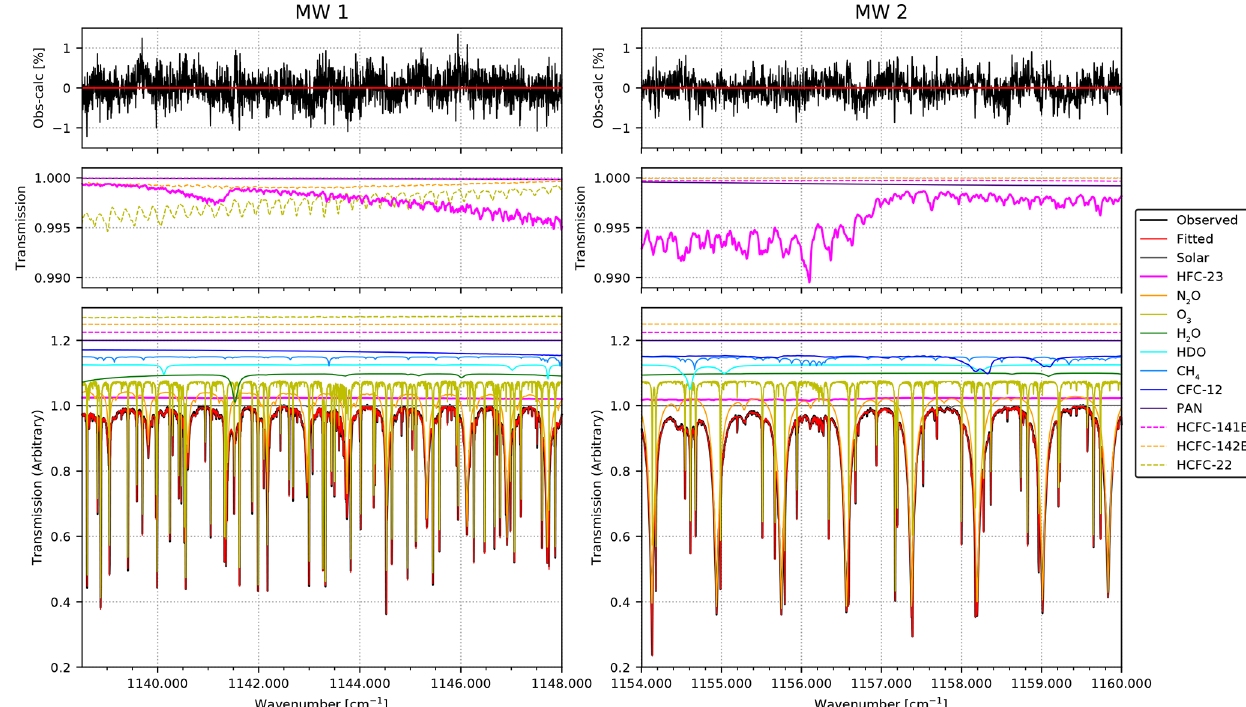
Figure 3. Typical spectral simulation results of the two HFC-23 retrieval micro-windows (left panel: MW1; right panel: MW2) fitted to the observed spectrum at Syowa Station on 9 November 2011 at 13:47UTC. The top two panels show the residuals (observed minus calculated) of the fittings for MW1 and MW2. The middle two panels show the absorption contributions of HFC-23, PAN, HCFC-141b, HCFC-142b, and HCFC-22 in MW1 and MW2. The bottom two panels show the individual contributions from each interfering species, shifted by multiples of 0.025 for clarity, except the observed and the calculated lines. Table 3. Statistical summary of the fitted SNRs, the root mean square (rms) of the fitted residuals (observed minus calculated spectrum), the degrees of freedom for signal (DOFS), and the retrieved HFC-23 total columns at Rikubetsu and Syowa Station. The errors of the fitted rms, the DOFS, and the total columns are 1 standard deviation (1 σ ) around the averages. The numbers of HFC-23 retrievals ( N ) are divided into two parts: the number of retrievals used in this analysis (valid) and the total ones including those rejected (total). Site